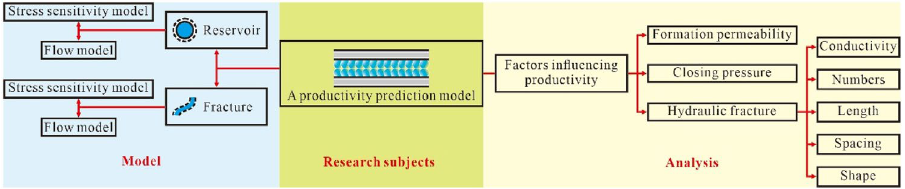
Fig. 2 Flow model for multi- fractured horizontal wells in tight oil